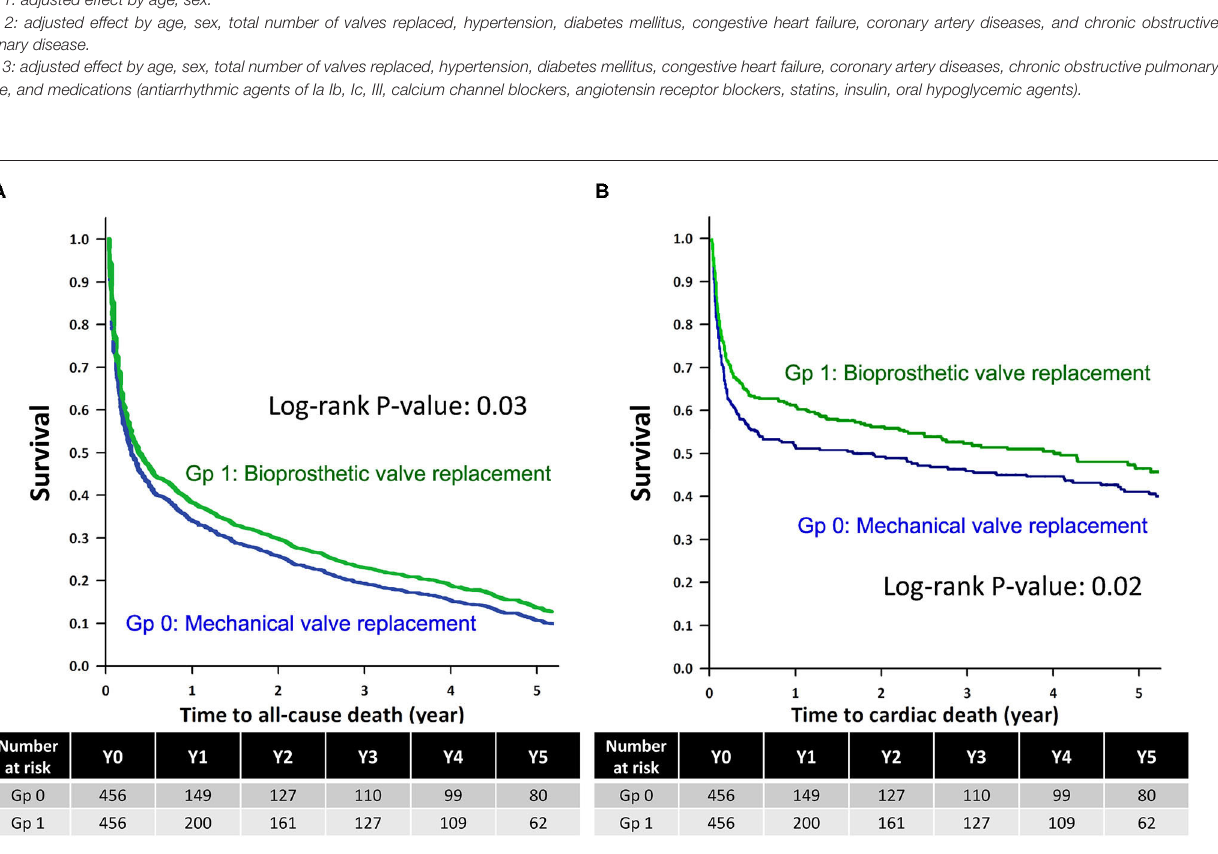
Frontiers in Cardiovascular Medicine |